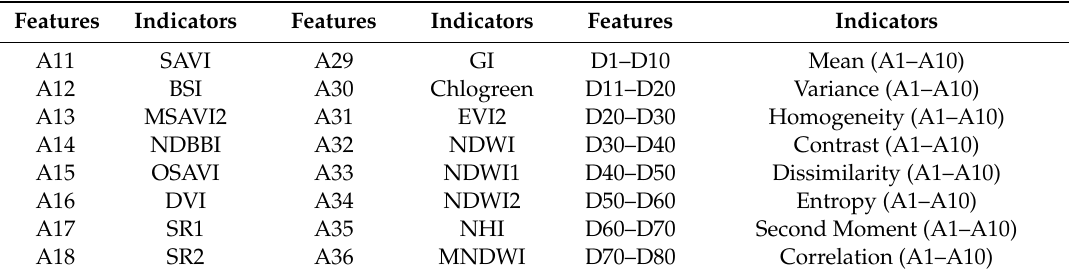
Table 2. Features selected for image classification.